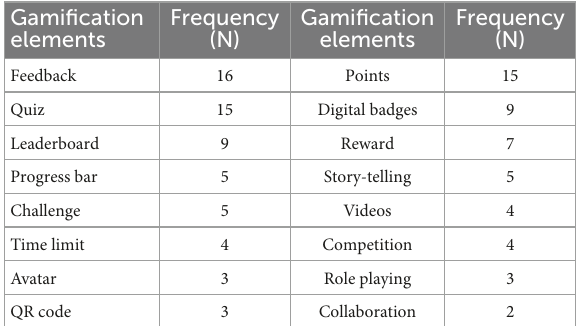
TABLE 1 The gamification elements used in the publications